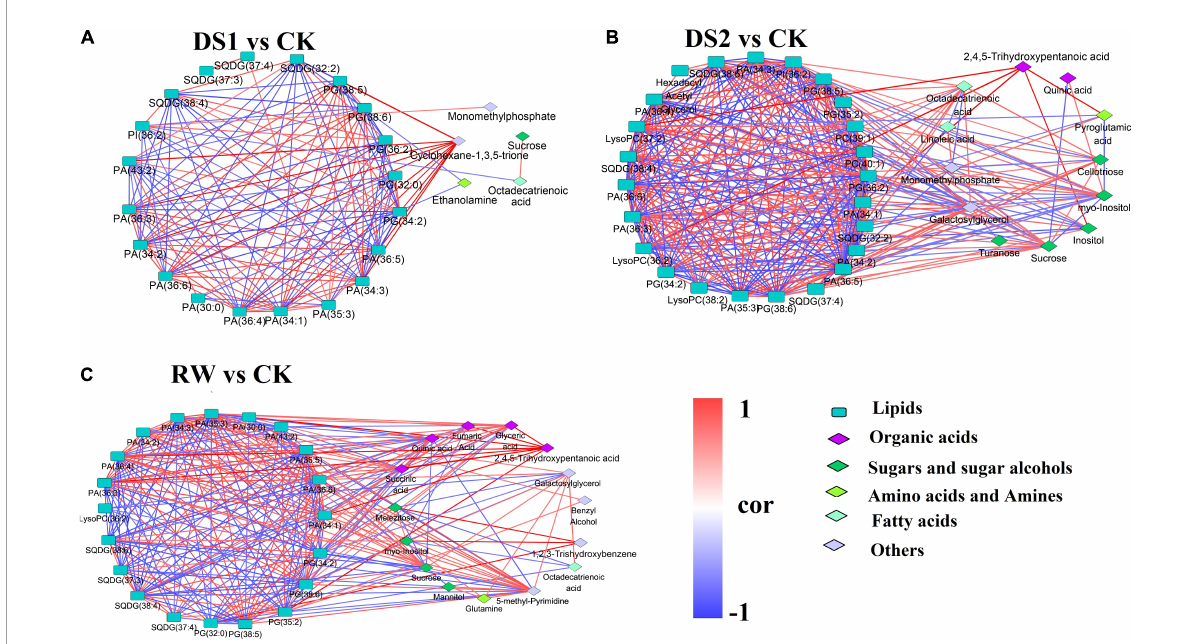
FIGURE6 Network map of correlation analysis among differential metabolites: (A) DS1 vs. CK; (B) DS2 vs. CK; (C) RW vs. CK. Metabolites represented by rounded rectangles were lipids. Metabolites represented by diamond were primary metabolites detected by GC-MS. The same color indicates metabolites in the same metabolic function group. Correlations are shown by connected lines. Red lines are positive correlations, and blue lines are negative